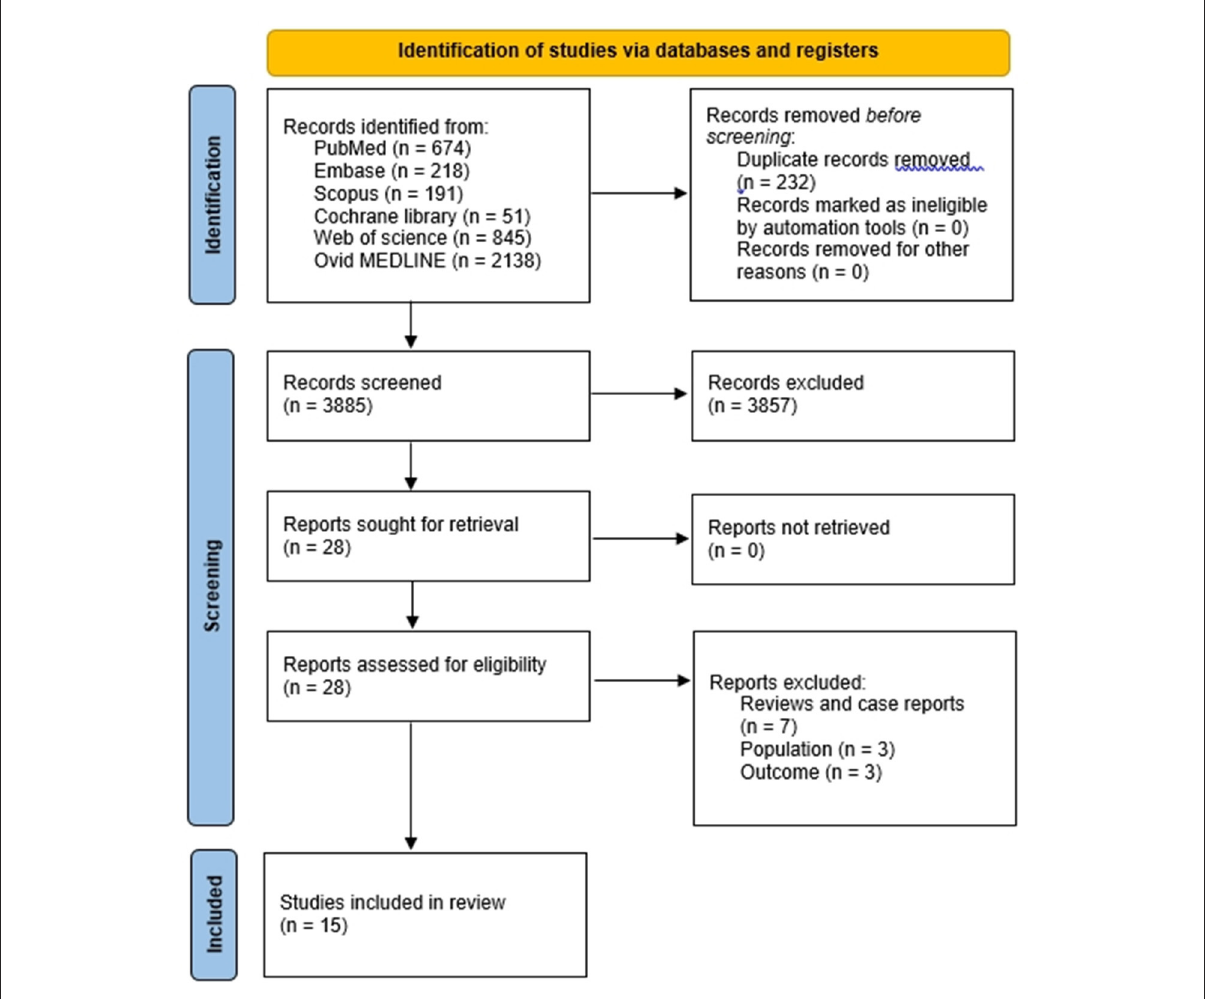
FIGURE1 Flow diagram of the study selection